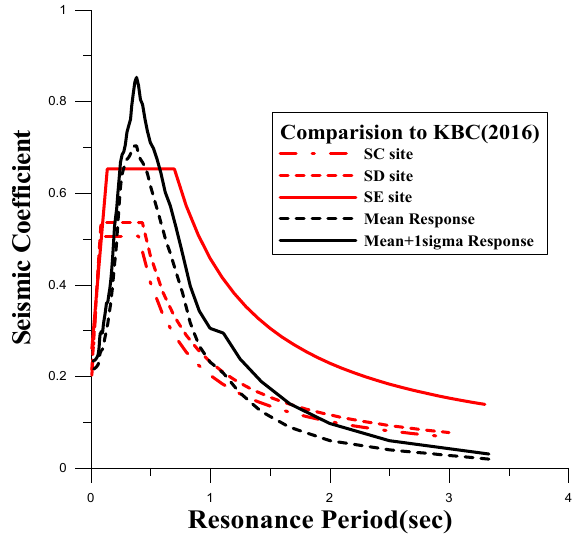
Figure 12. Comparison of the response spectra of 8 stations with KBC (2016) for SC, SD, and SE soil conditions (2400-years return periods). The x - and y -axes represent the structure resonance period and response spectrum, respectively.